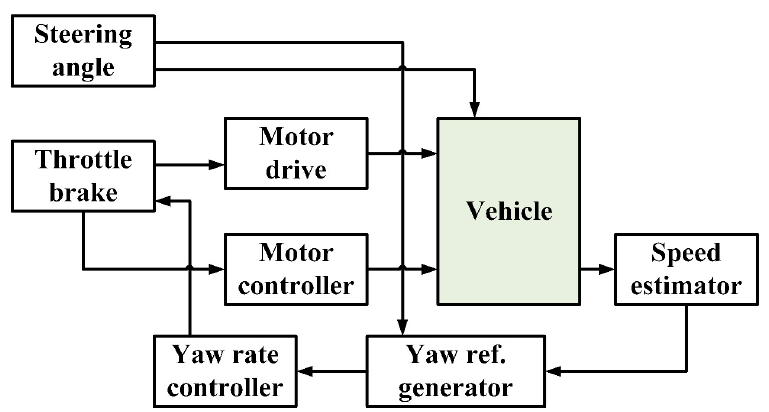
Figure 68. Working principle of vehicle stability system proposed by Tahami et al. A neural network was used in the yaw reference generator [25].